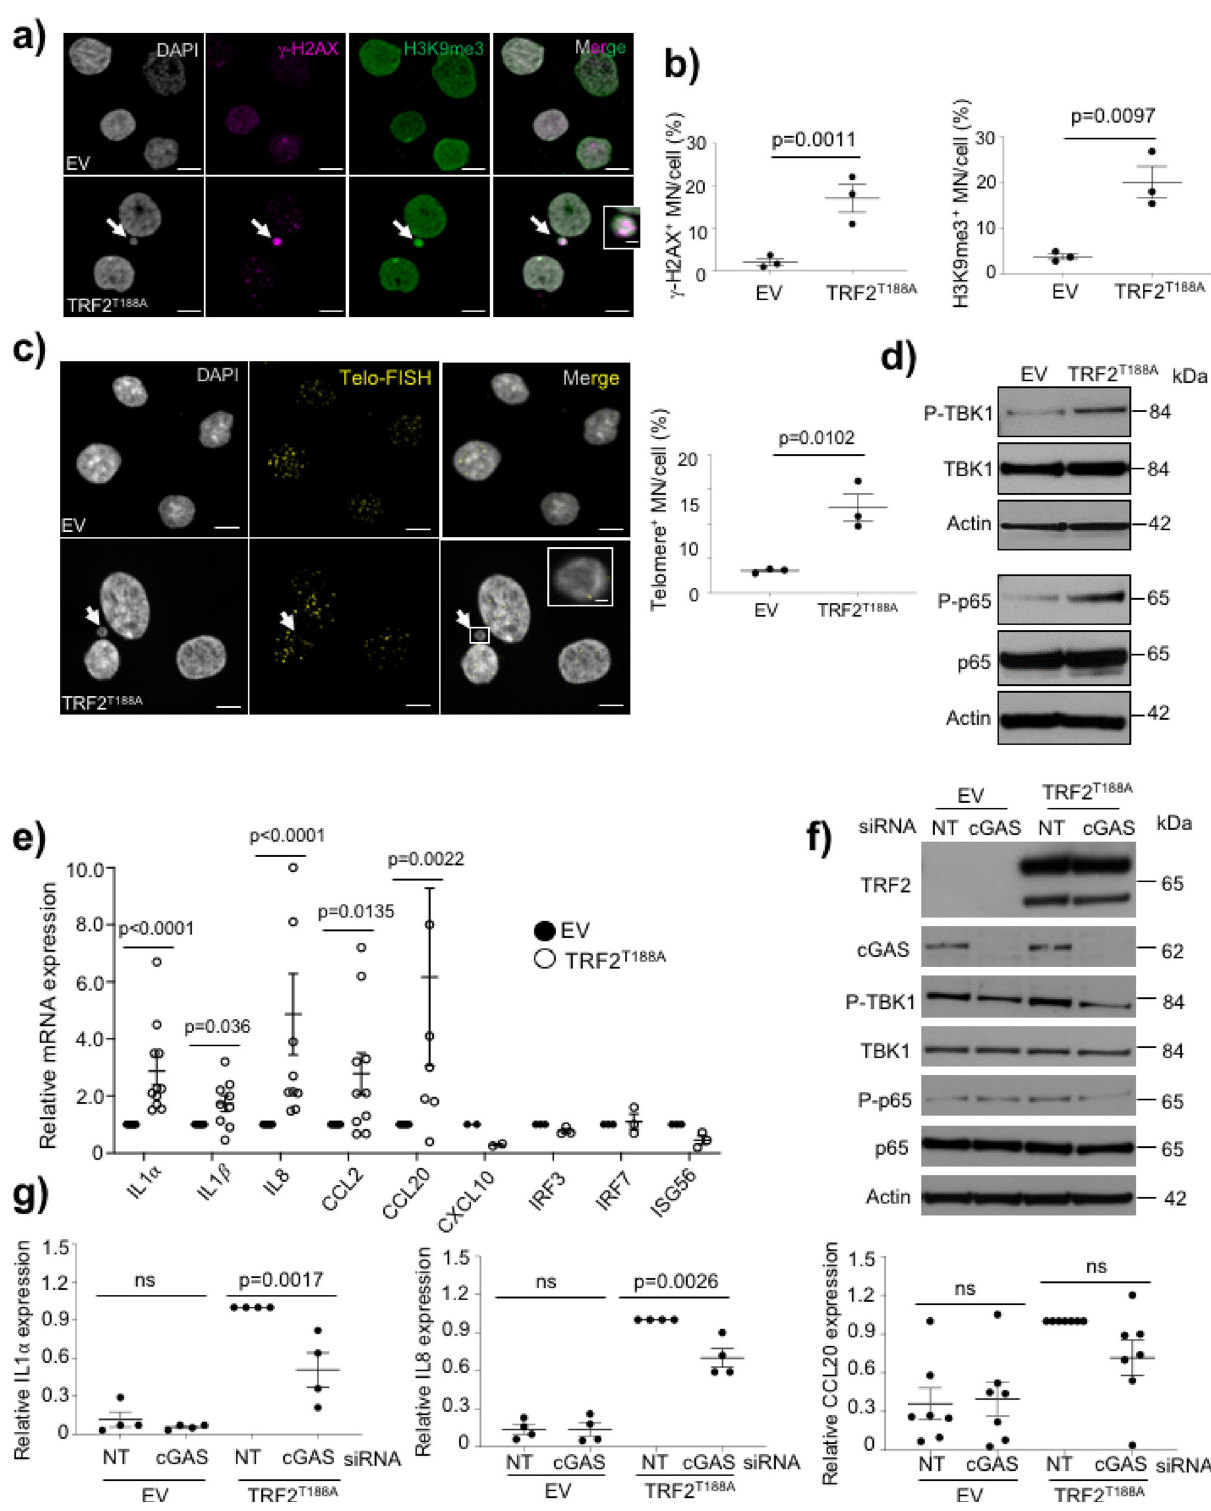
VSMC-speci fi c TRF2 T188A expression recruits in fl ammatory and immune cells to the vessel wall . We analyzed LCCA cryo- sections of TRF2 T188A and control mice at 28 days after ligation to assess whether the increased neointimal area is primarily owing to VSMCs, other cell types, or non-cellular material. The number of DAPI + nuclei was increased in both media and neointima of TRF2 T188A mice; however, confetti + VSMC numbers and % were